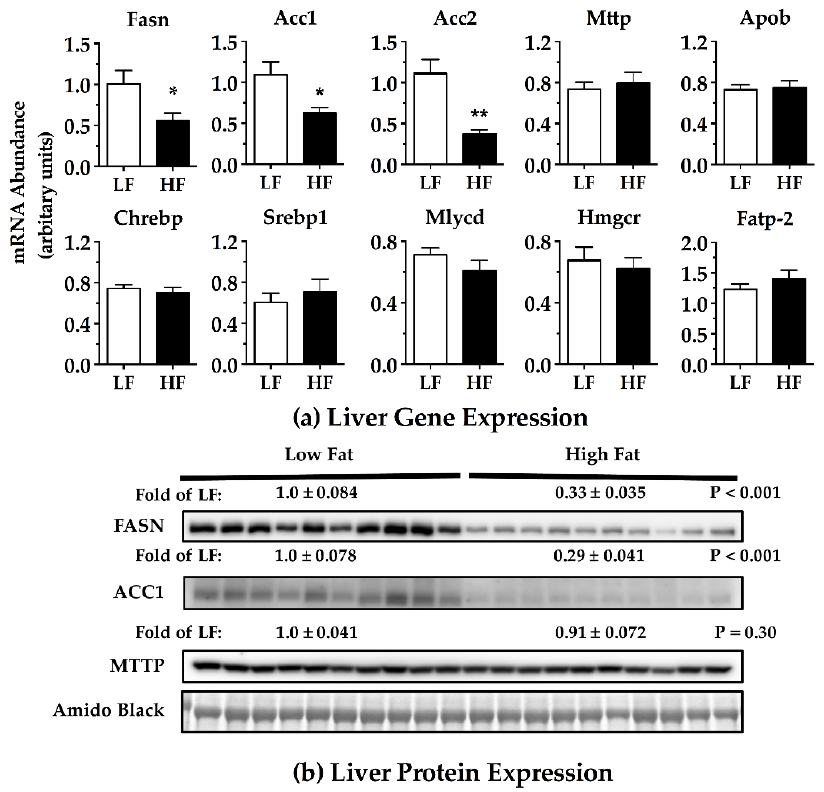
Figure 6. Liver fatty acid metabolism related gene (bar graphs) and protein (Western blots) expression in male C57BL/6J mice fed a low ‐ fat (LF) or high ‐ fat (HF) diet for 7 weeks prior to assessment. Gene expression was normalized to 18S RNA. Protein densitometry was normalized to an amido black stained protein band of approximately 150 kDa. Protein densitometry is displayed as fold of LF, mean ± SEM. Mice were fasted 5–6 h prior to collection of the livers. Abbreviations are listed in Table 2. * p < 0.05; ** p < 0.01. Student two ‐ tailed t ‐ test. LF n = 10; HF n = 10.